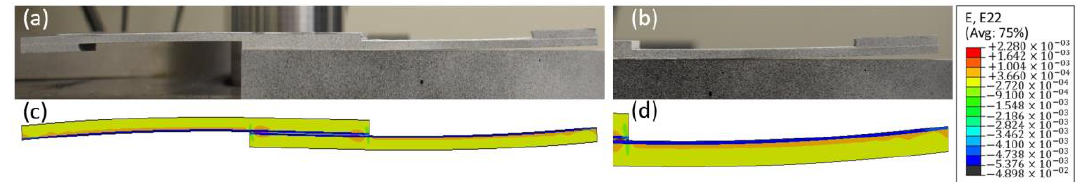
Figure 6. SLJ deformation after curing: ( a ) specimen produced before DIC analysis (and detail ( b )) and ( c ) specimen model after thermal step (and detail ( d )).